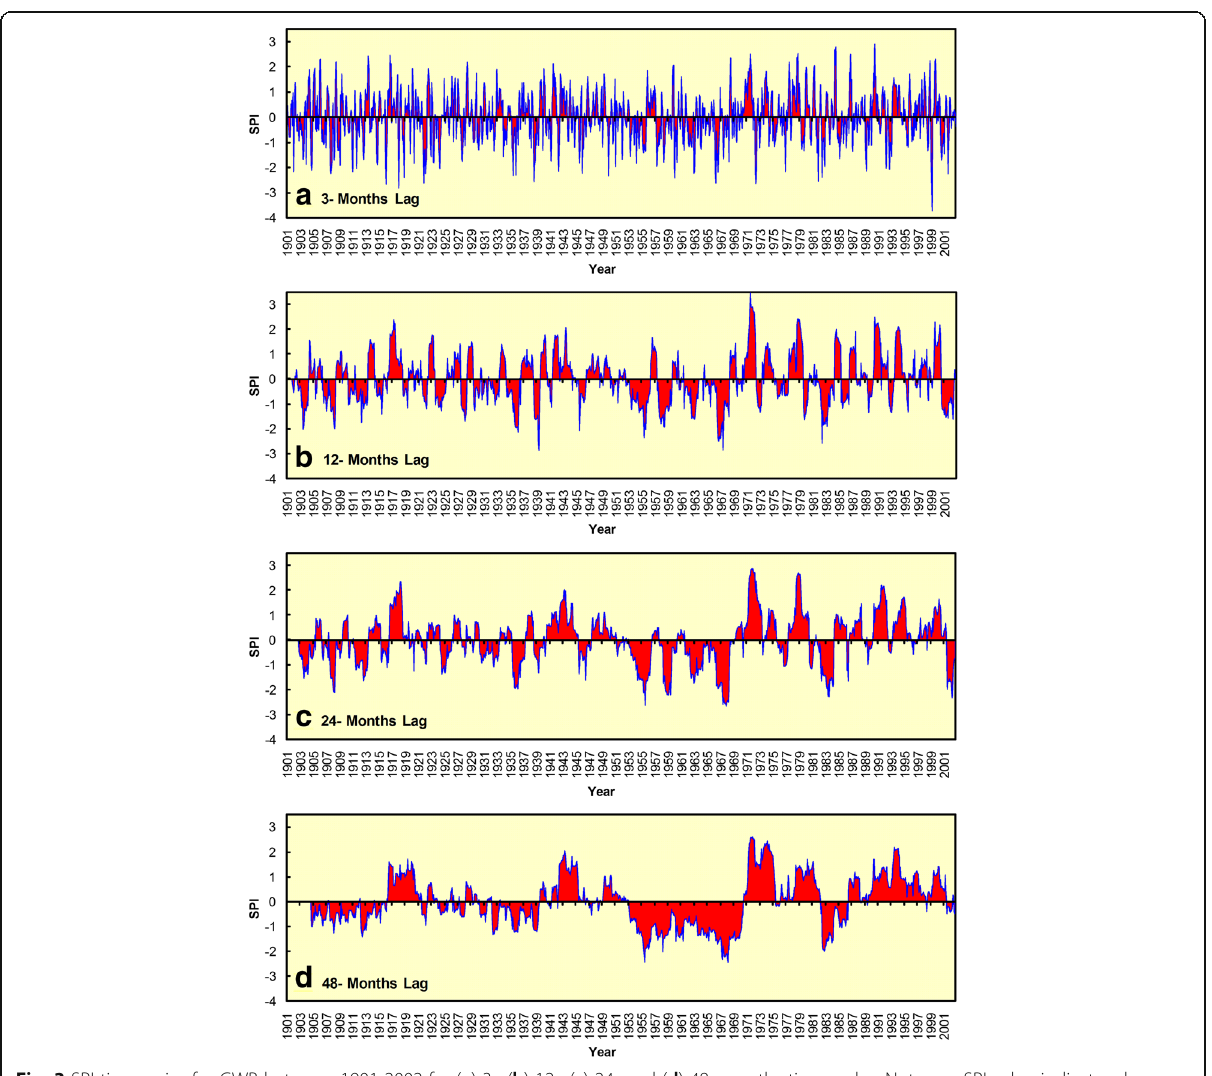
Fig. 3 SPI time series for GWB between 1901-2002 for ( a ) 3-, ( b ) 12-, ( c ) 24- and ( d ) 48- months time scales. Note: -ve SPI value indicates dry condition and +ve SPI value indicates wet condition, If SPI become more – ve or +ve, the conditions become more severely dry or wet